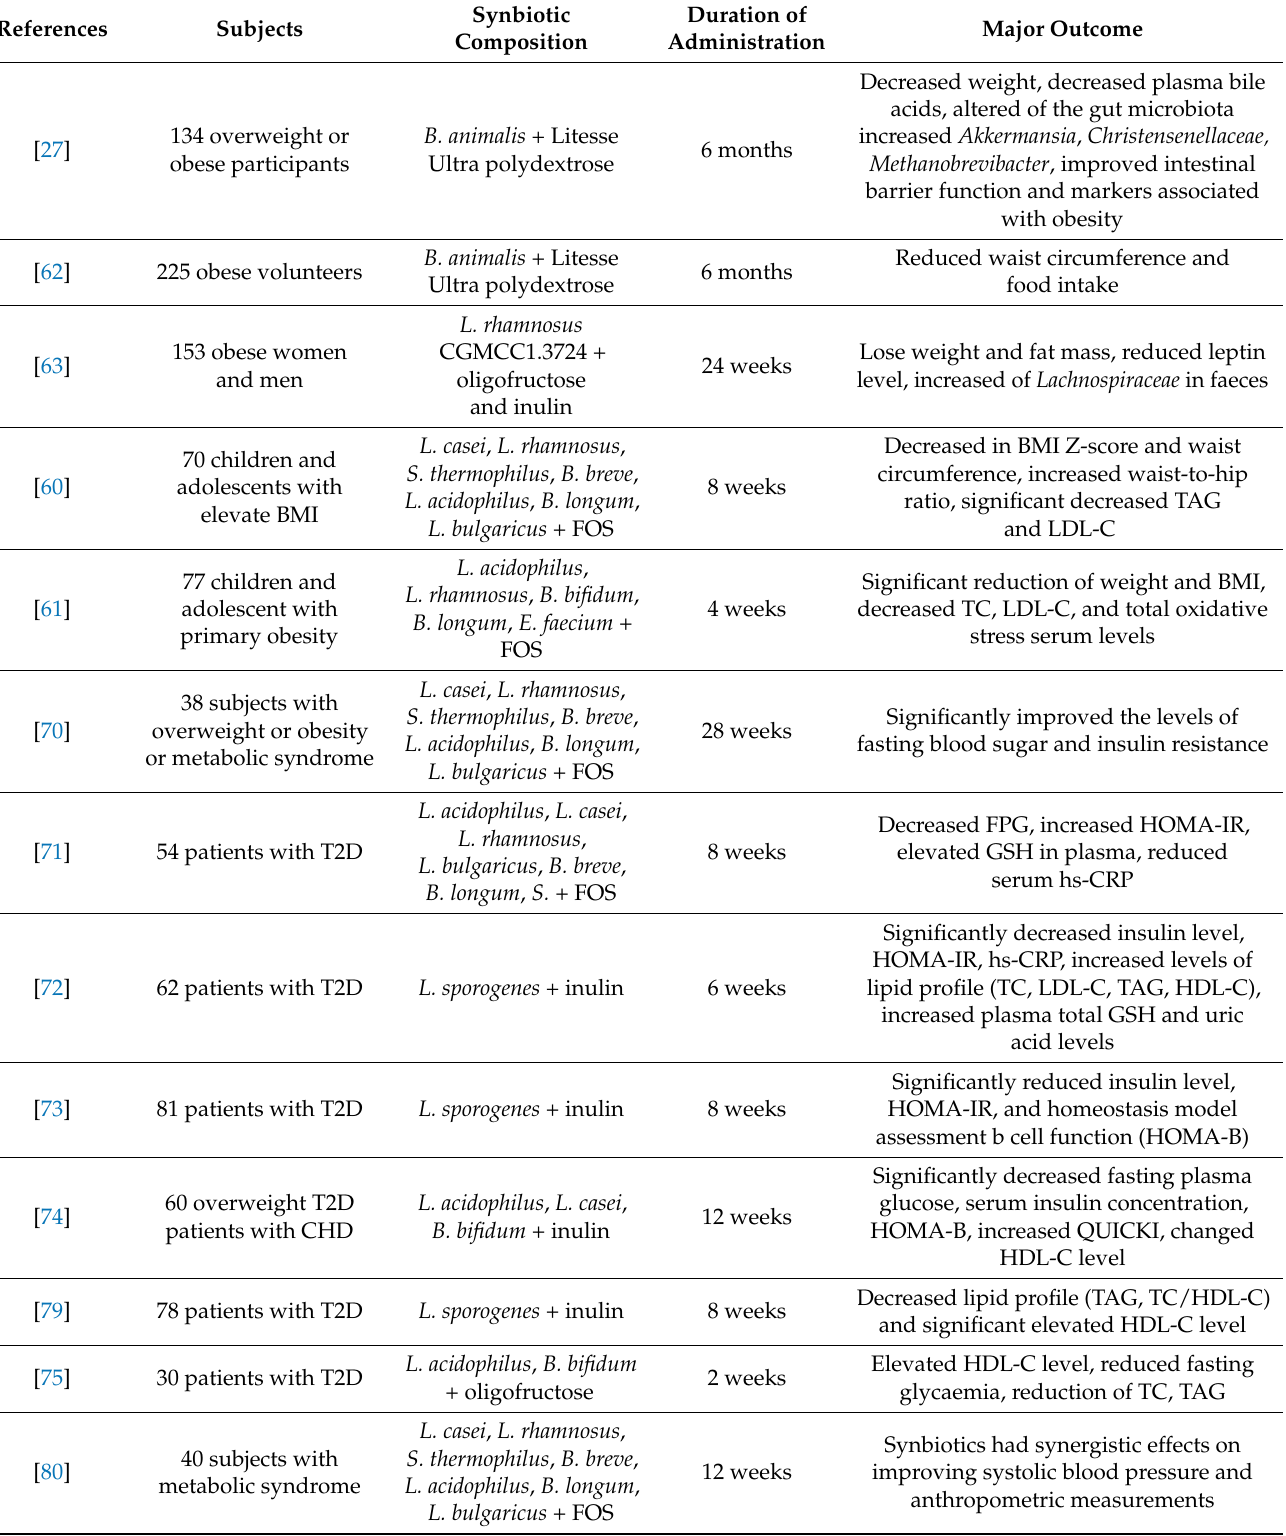
Table 2. Clinical trials concerning the effect of synbiotics on obesity and obesity related metabolic disorders in children and